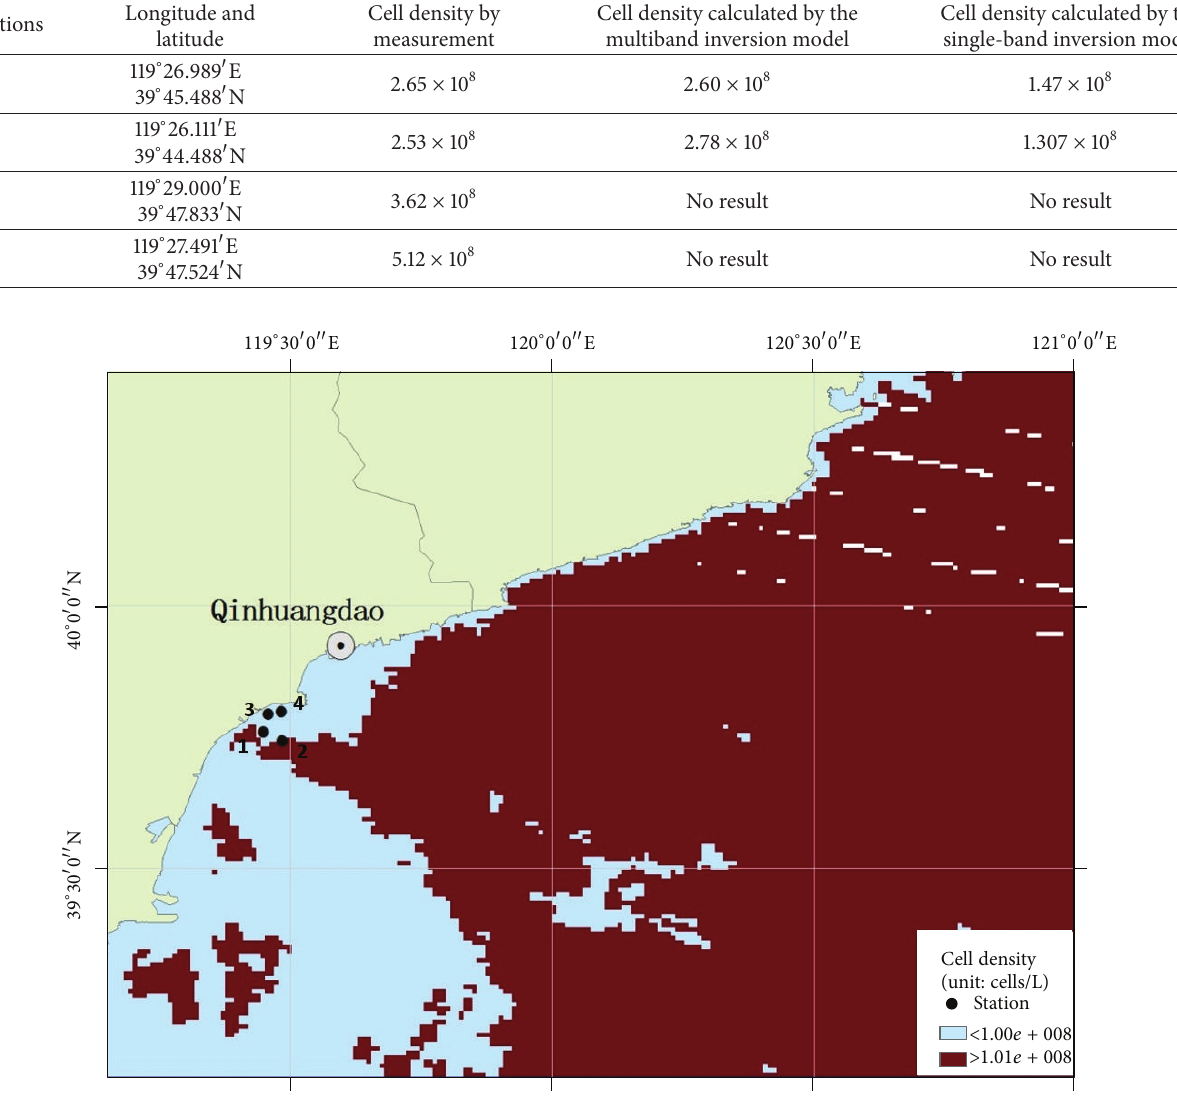
Table 3: Comparison of monitoring result and inversion result (cells/L).